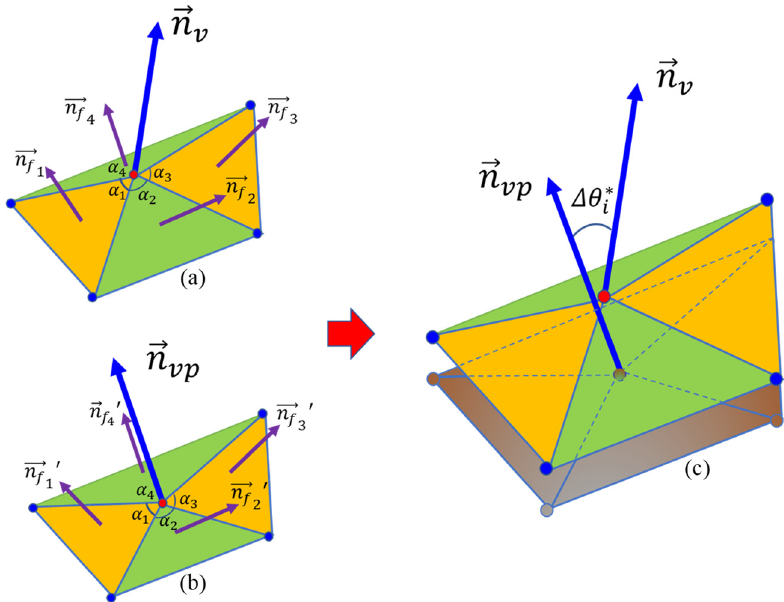
Figure 5. Angle difference between two sub-surfaces with different RLS: ( a ) normal vector for target sub-surface point; ( b ) normal vector for the point with same polar radius direction on previous sub-surface; ( c ) angle difference.